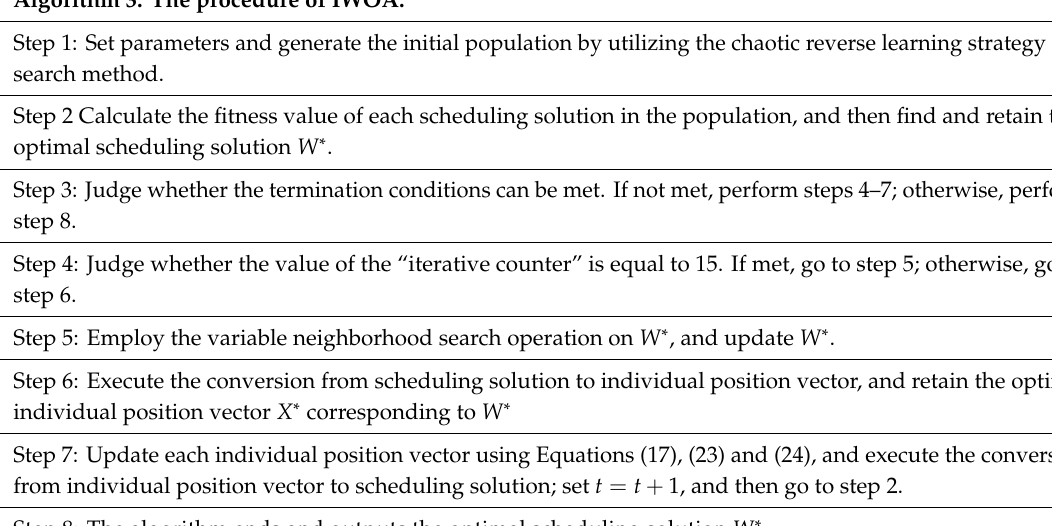
Algorithm 3. The procedure of